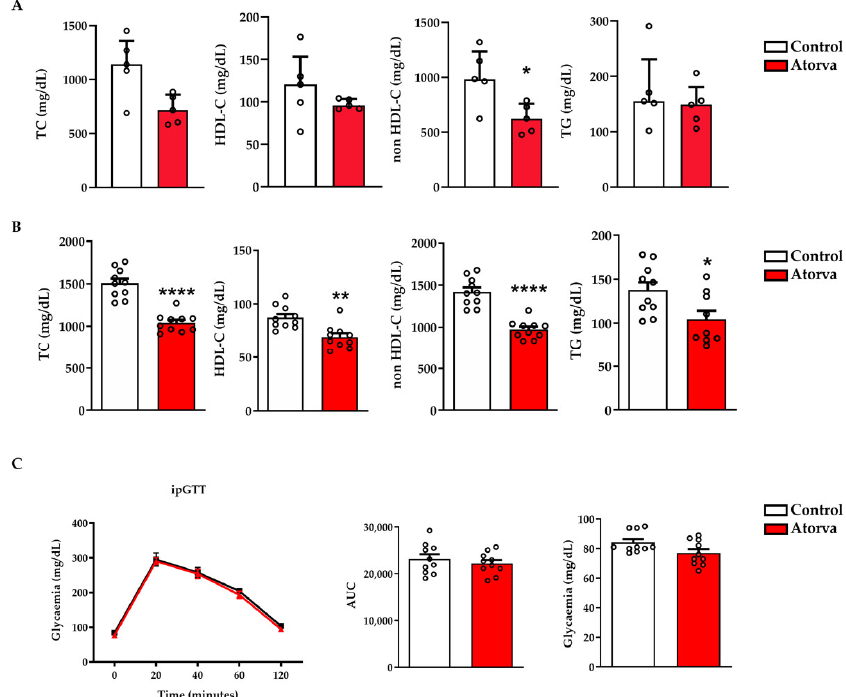
Figure 1. ApoE -/- mice were fed with HFHC (Control) and HFHC plus atorvastatin (Atorva). Lipid profile was assessed after 1 week ( A ) and 12 weeks ( B ) of diet. Fasting glycaemia after 12 weeks ( C ). Glucose (1 g/kg) was administered intraperitoneally and glycaemia measured after 20, 40, 60 and 120 min. Between-group differences were assessed by Mann–Whitney test ( A ) and by Student’s t - test ( B , C ). * p < 0.05; ** p < 0.01; **** p < 0.0001. Data in panel A are depicted as median and interquartile range; those in ( B , C ) as mean ± SEM. Atorva, atorvastatin; AUC, area under the curve; HDL-C, high-density lipoprotein cholesterol; HFHC, high-fat high-cholesterol diet; ipGTT, intraperitoneal glucose tolerance test; TC, total cholesterol; TG, triglycerides. n = 10 in each group. ° stands for individual values.